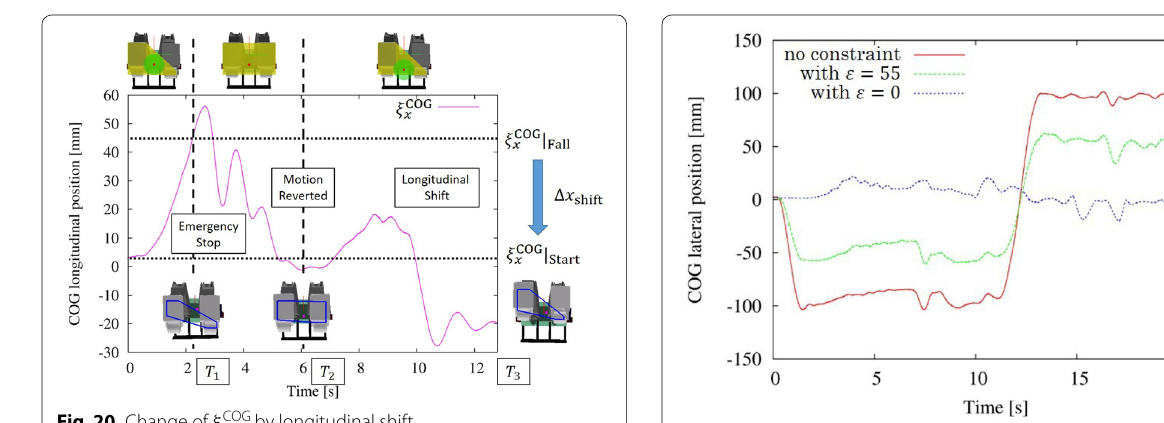
Fig. 21 Comparison of COG lateral